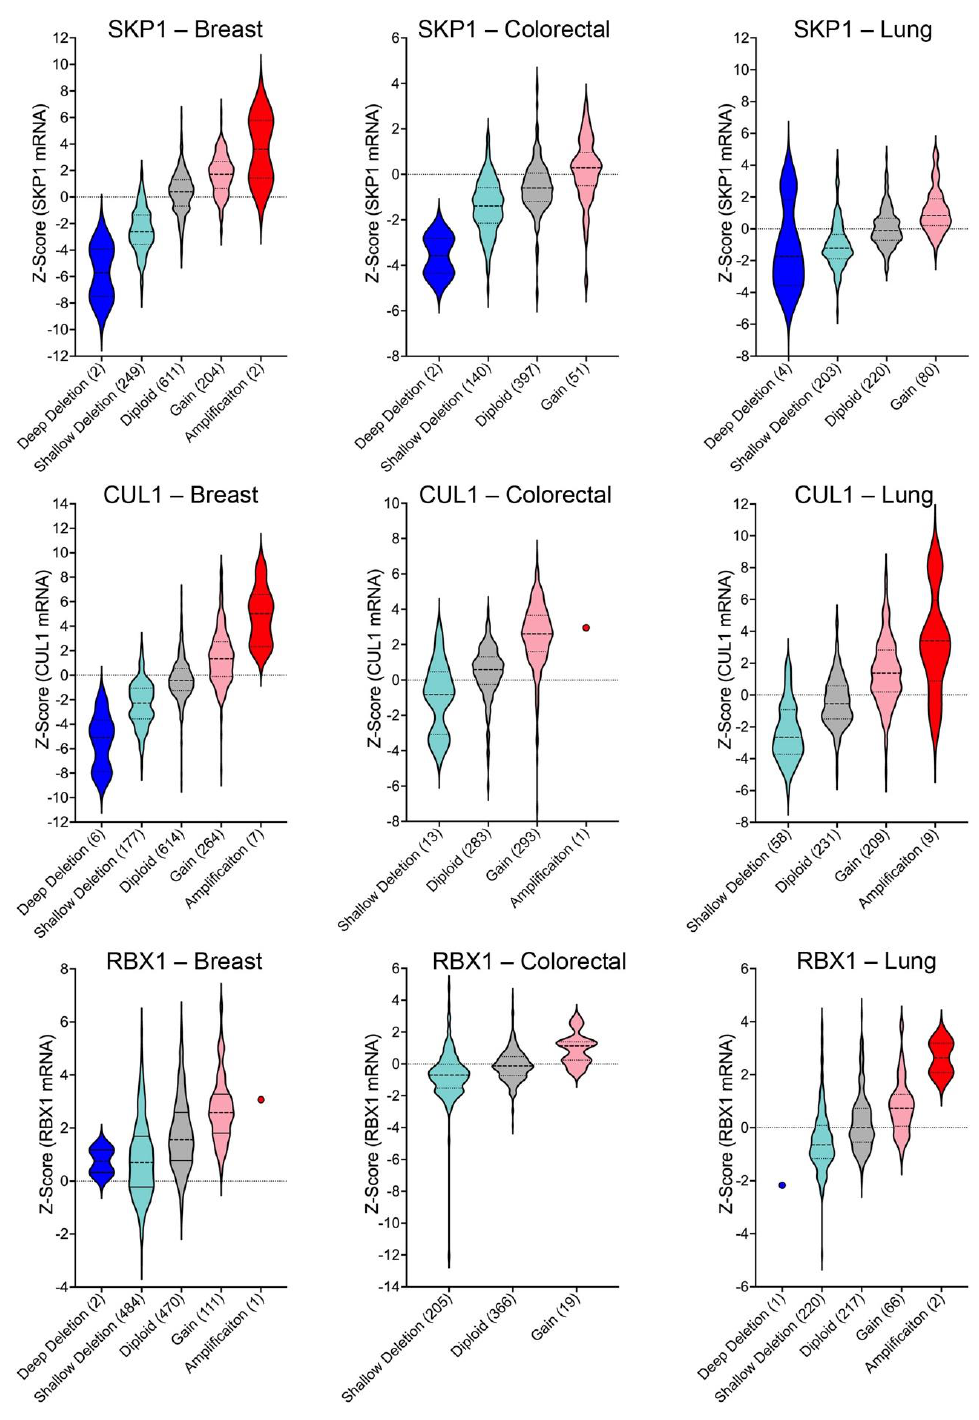
Figure 4. Gene copy number changes correspond with SKP1 , CUL1 , and RBX1 expression levels. (A) Violin plots of TCGA pan-cancer data [58] from the three most commonly diagnosed cancers (i.e., breast, colorectal and lung). SKP1 (top), CUL1 (middle), and RBX1 (bottom) copy number alterations (deep deletions; shallow deletions; gains; amplifications) and diploid cases are presented along the x-axis with total case numbers indicated within brackets. Note that categories with only single cases are identified by circles and that in general, deep deletions, and amplifications are rare.